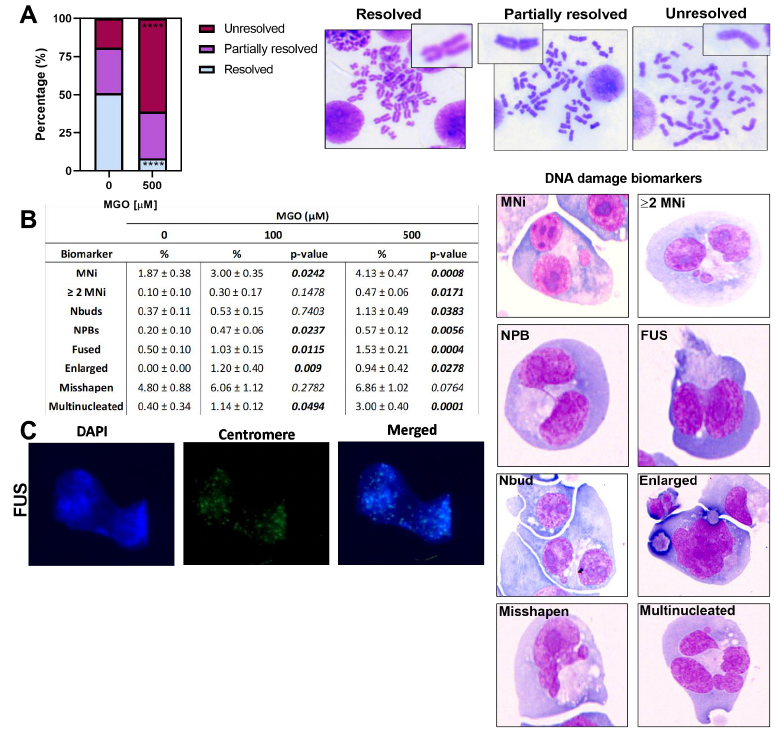
Figure 3. ( A ) Analysis of sister chromatid resolution, scored as (i) resolved, (ii) partially resolved, and (iii) unresolved; ( B ) analysis of DNA damage biomarkers. Columns show the percentage of cells displaying each biomarker and its significance determined by one-way ANOVA when compared with the control. Representative photomicrographs of each nuclear anomaly are displayed on the right. MNi, ≥2 MNi, NPB, FUS, and Nbuds were scored in binucleated cells using the CBMNcyt assay. Enlarged, misshapen, and multinucleated cells were scored in normally dividing cells; ( C ) fluorescence in situ hybridisation analysis of fused nuclei. Data are mean ± SD ( n = 3). A one-way ANOVA, followed by a Dunnett post hoc was conducted to determine statistical significance **** p < 0.0001.